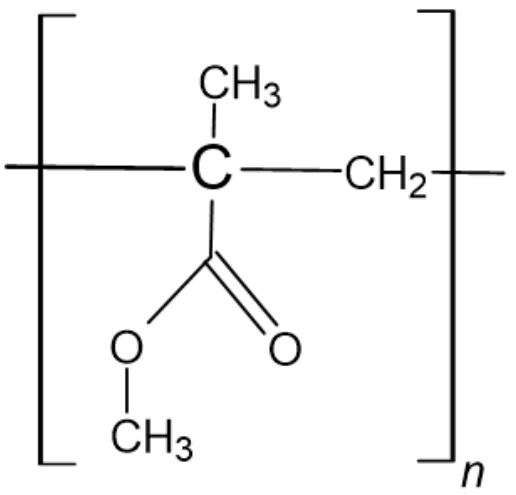
Figure 4. Poly (methyl methacrylate) structure.